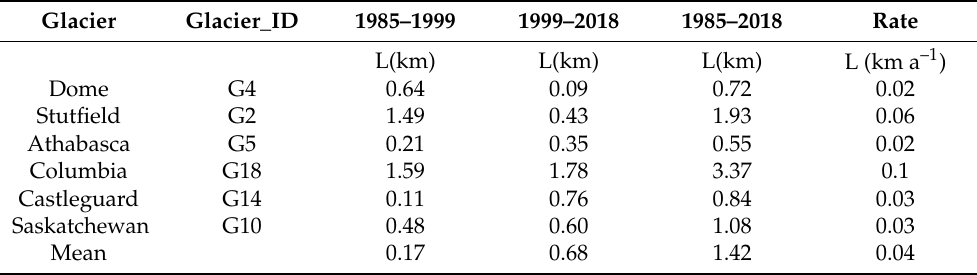
Table 2. Glacier retreat of the Athabasca, Castleguard, Dome, Saskatchewan, Columbia, and Stutfield Glaciers between 1985 and 2018. Glacier Glacier_ID